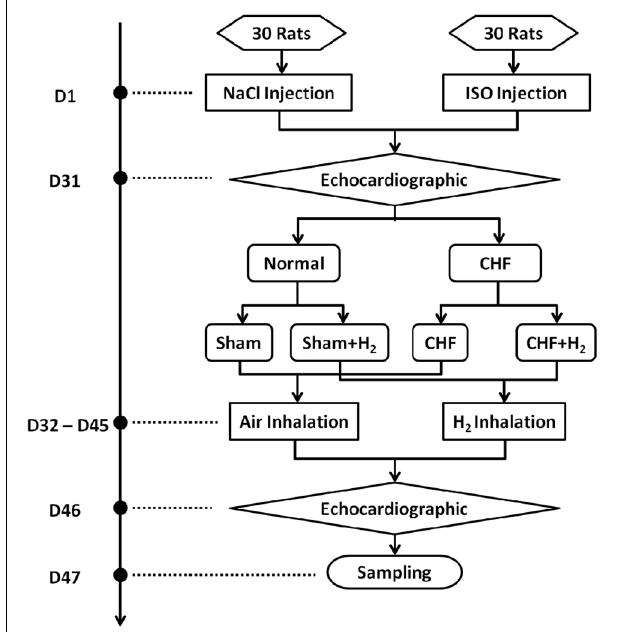
FIGURE 1 | The time course of the study on each animal. The protocols and interventions on each animal and when they were performed were indicated.